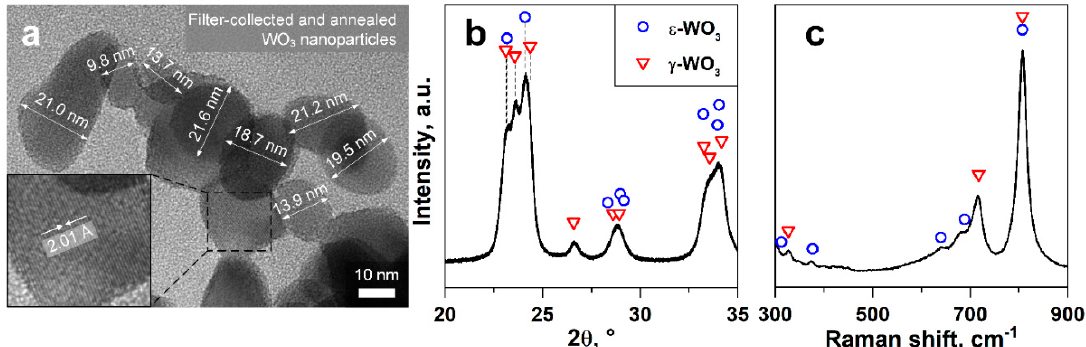
Figure 1. Material characterization. ( a ) TEM image with marked primary particle sizes in nm with inset at higher magnification, showing the lattice orientation and spacing in Å. ( b ) XRD pattern and ( c ) Raman spectrum of the filter-collected and annealed WO 3 particles. Reference peak positions of monoclinic γ -WO 3 (triangles, ICSD 80056) and ε -WO 3 (circles, 84163).